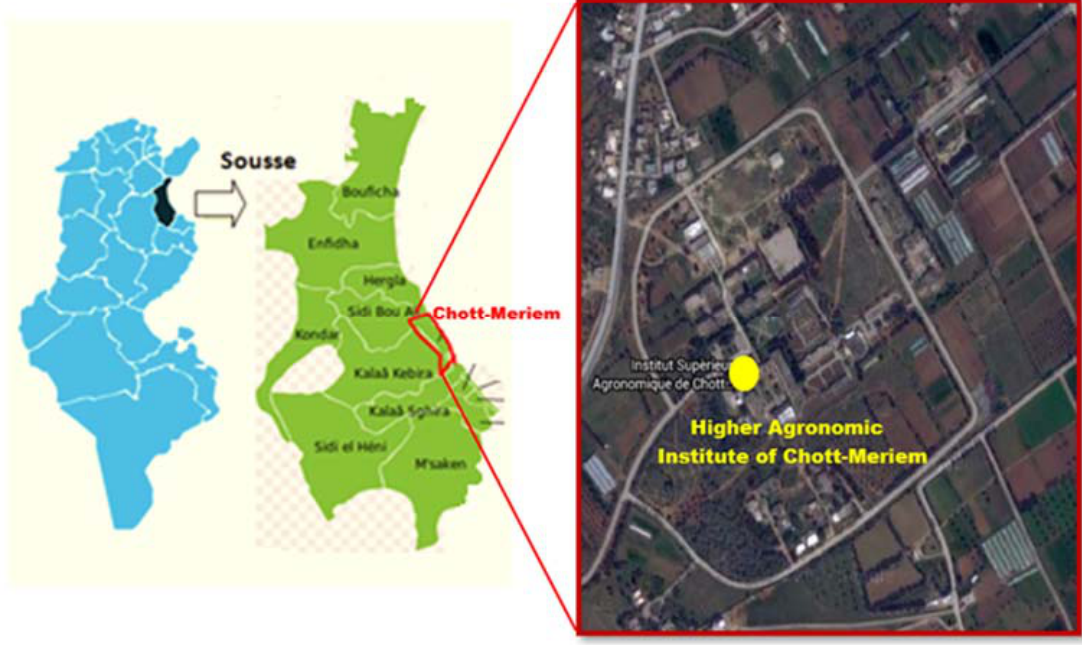
Figure 1. Map of study site (Chott Mariem, Sousse, Tunisia).